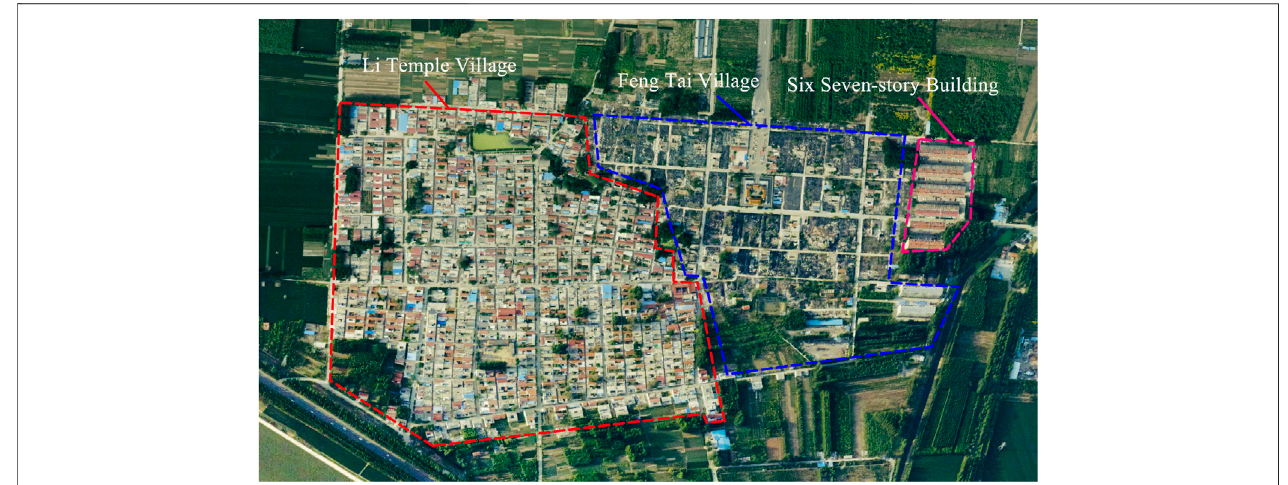
FIGURE 12 | Distribution of surface buildings.